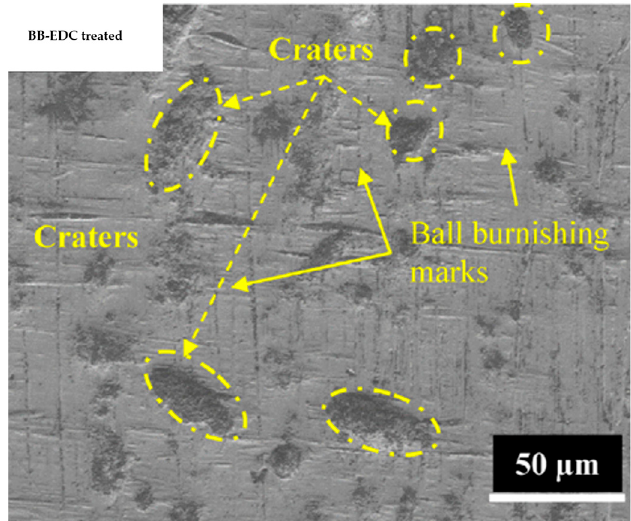
Figure 25. SEM micrograph of the BB-EDC treated β -phase Ti alloy surface [133]. (With kind per- mission from Elsevier).